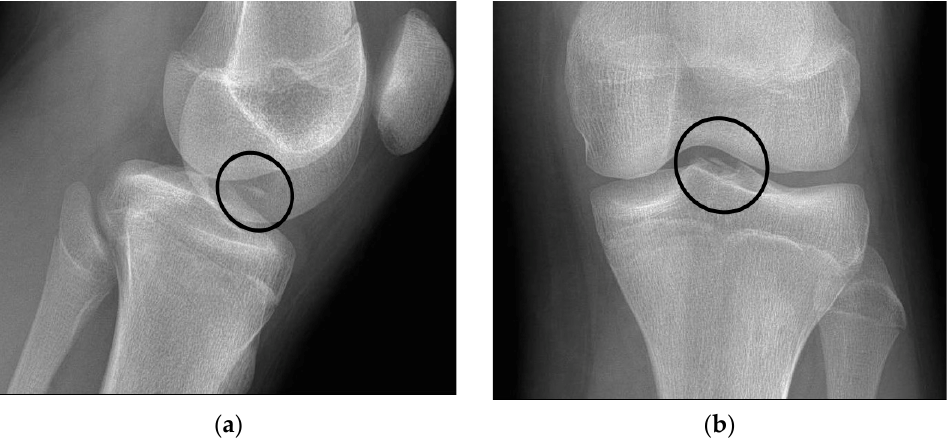
Figure 3. X-ray radiographs of the patient in two planes, ( a ) anteroposterior (AP) view and ( b ) lateral (L) view, of the injured knee. The fractured fragment is highlighted in the figure.